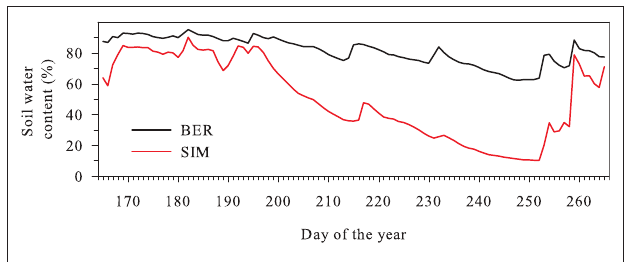
Figure 2 | Soil water content measured in the two black spruce stands of the boreal forest of Quebec, Canada.